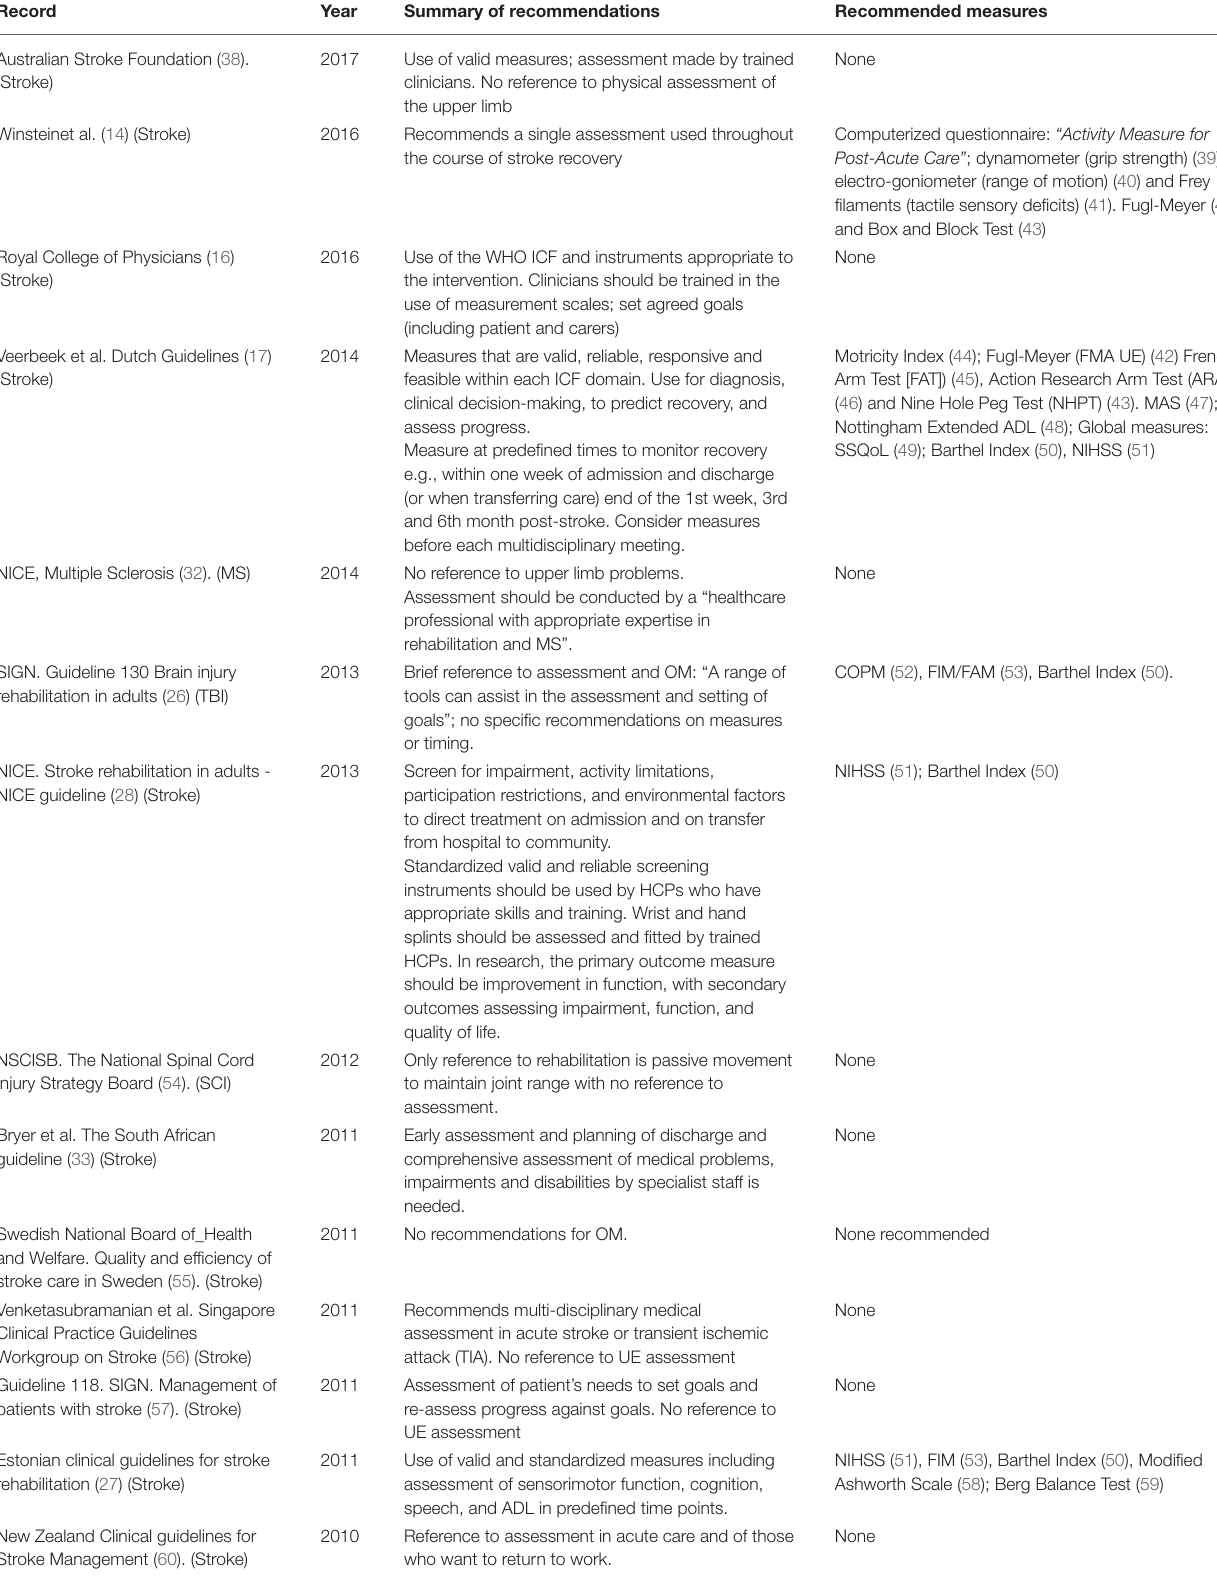
TABLE 1 | Summary of the National Guideline records included in the